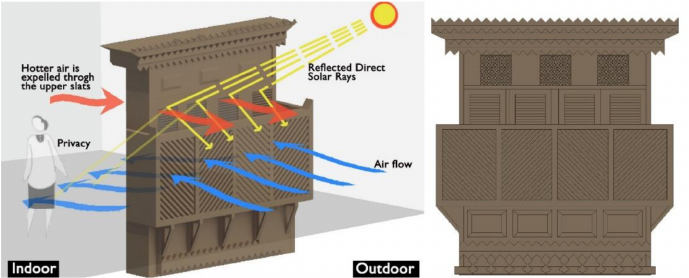
Figure 1. Example of Mashrabiya demonstrating the principal functions. Reproduced from Bagasi and Calautit